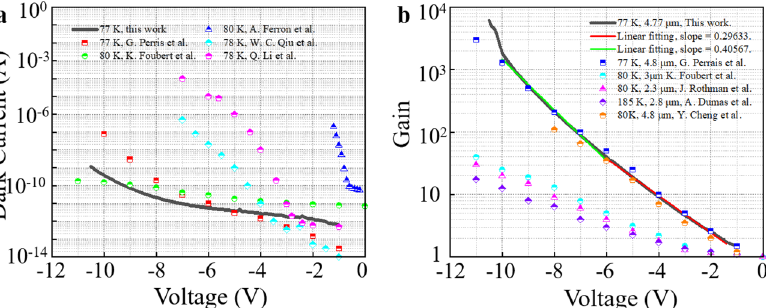
Fig. 5 Key performance of the designed avalanche detector and comparisons with reported devices. a The measured dark current of our own device and the comparisons with others work. b The measured avalanche gain of our device and comparisons with others work. Experimental results reported by other groups are included for